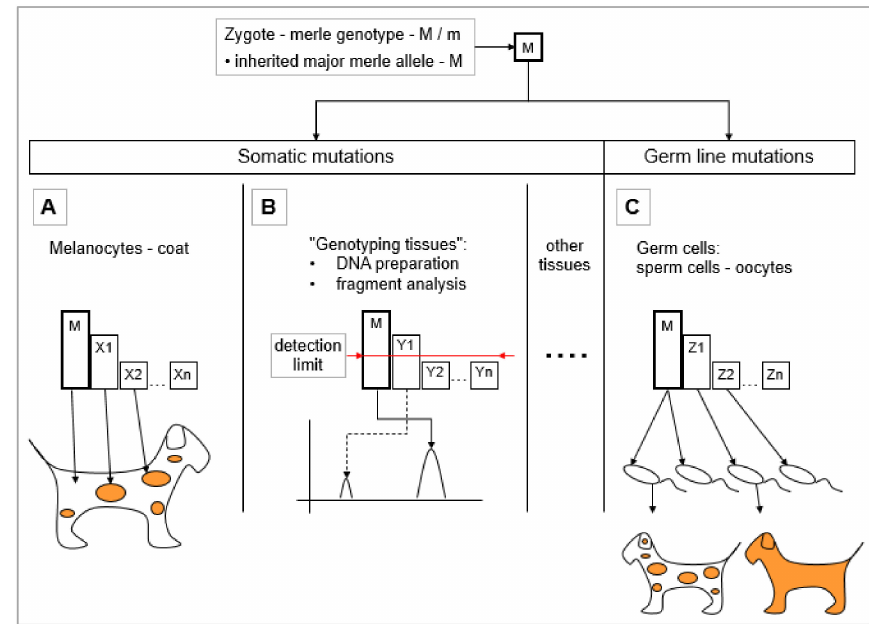
Figure 5. The fate of merle allele ( M ) mutations in the somatic and germ cells. The sketch shows a spotted, heterozygous individual having a mutant, standard merle allele ( M ) and a wild allele ( m ). The standard merle allele is capable of both extension and contraction. An inherited, single merle mutant allele ( M ) may mutate further within the di ff erent somatic tissues and within the germ line. In these tissues, the largest cell population will carry the major inherited M allele and according to the high mutation rate of the poly(T) sequence, smaller cell populations containing di ff erent minor mutant merle alleles, will also exist. The mutational spectra and the proportions of the mutant sector within the various tissues do di ff er and thus, are denoted here using di ff erent letters. ( A ) Melanocytes (mutations X1-Xn); ( B ) “genotyping tissues” (for details see Section 5.1.2; mutations Y1-Yn); and ( C ) germ line (mutations Z1-Zn) are shown. ( A ) In the case of melanocytes, the major mutant cell population will determine the overall coat color, while the di ff erent minor mutant cell subpopulations will result in the development of individual patches. ( B ) When we perform genotyping from the DNA of blood lymphocytes, the mutant spectrum structure will be similar. In addition to the major cell population containing the M allele, the largest mutant cell population(s) will be detected depending on the resolution of the genotyping platform. Smaller mutant cell subpopulations under the detection limit remain invisible. ( C ) The mutant spectrum of the germ line might also contain mutant cell subpopulations, but not necessarily the same ones as in other tissues. If we analyze these cell populations as a “genotyping tissue” with a genetic analyzer, we will observe a similar spectrum to that shown in ( B ). However, if we analyze several progenies of this individual, we will evaluate a non-representative sample which will not